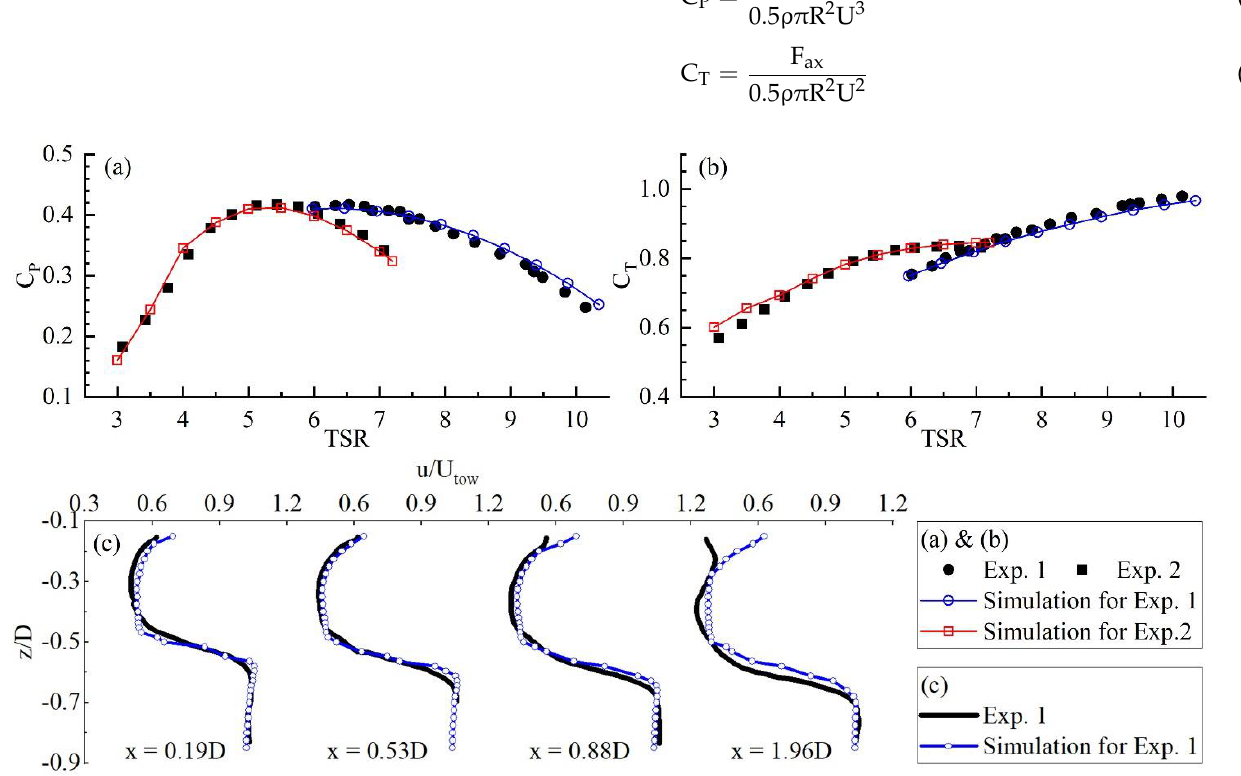
Figure 4. Comparison of performance and near-wake between simulations and experiments; ( a ) for C p , ( b ) for C T , and ( c ) for velocity distribution of near-wake.